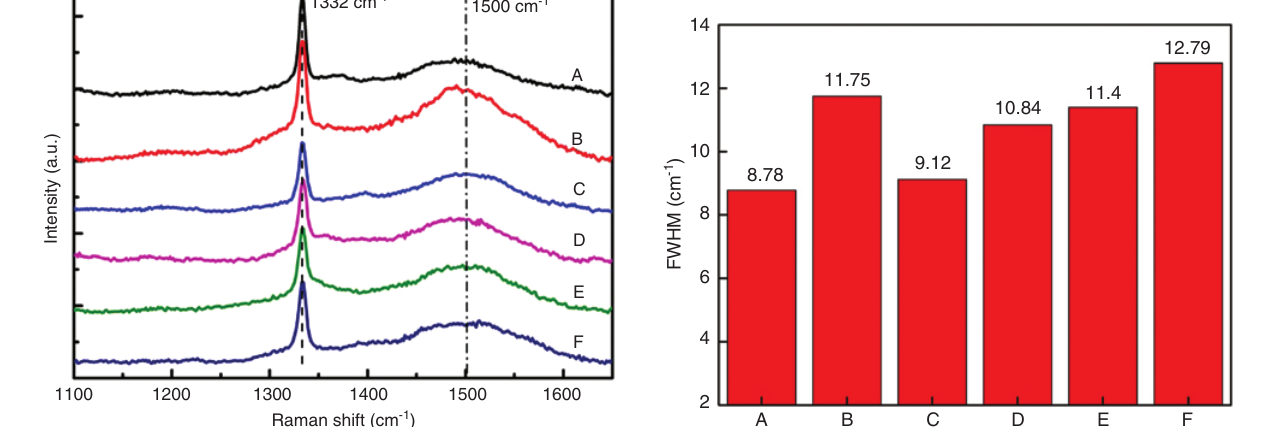
-0, Ar-0; (B) O -0, Ar-15; (C) O 2 2 -3, Ar-12; (F) O -4, Ar-11. 2 2